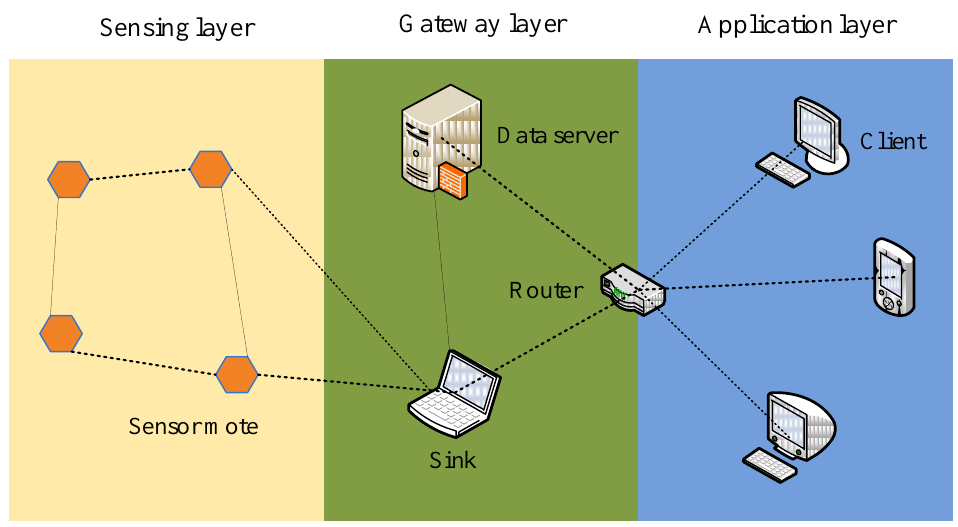
Figure 1. The architecture of the wireless corrosion monitoring system.